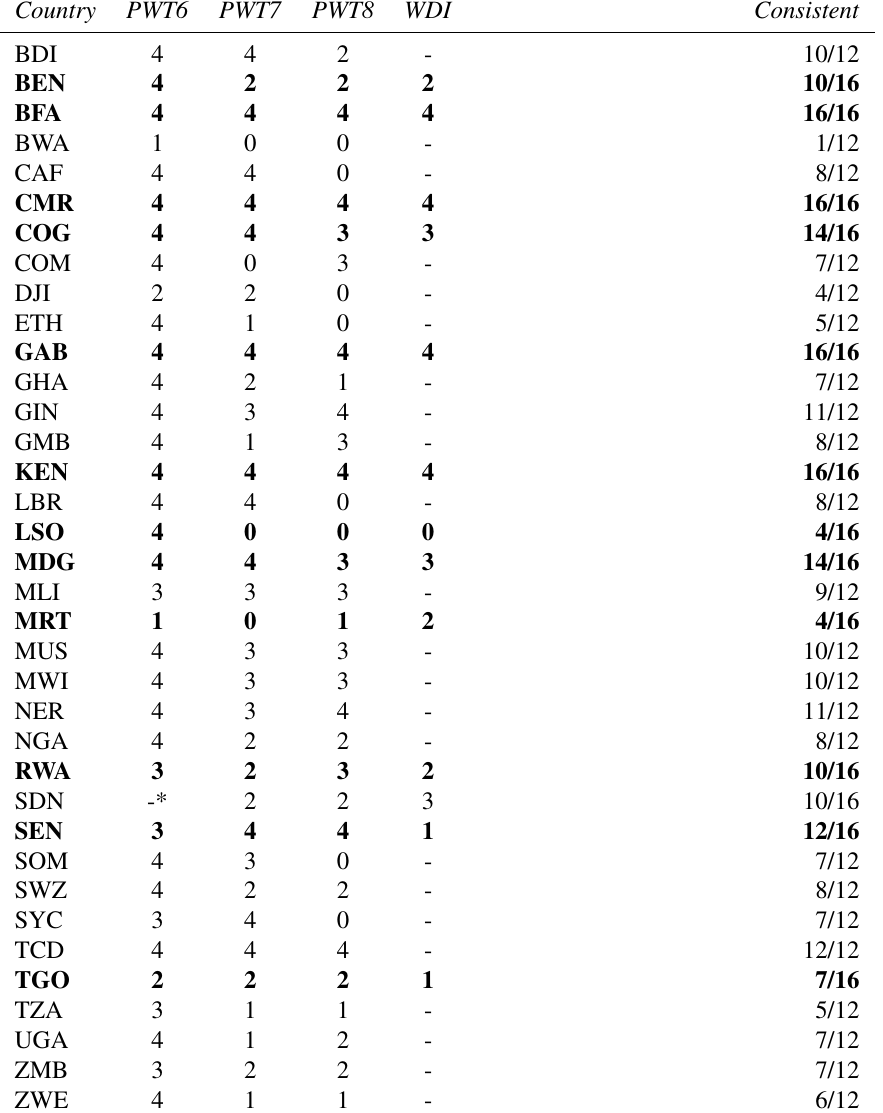
Table 11: Consistent coefficients by